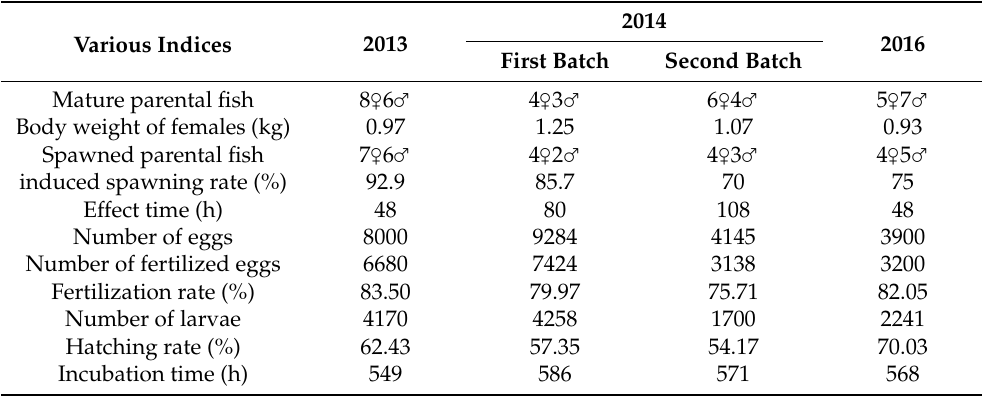
Table 1. The results of artificial propagation in 2013, 2014, and